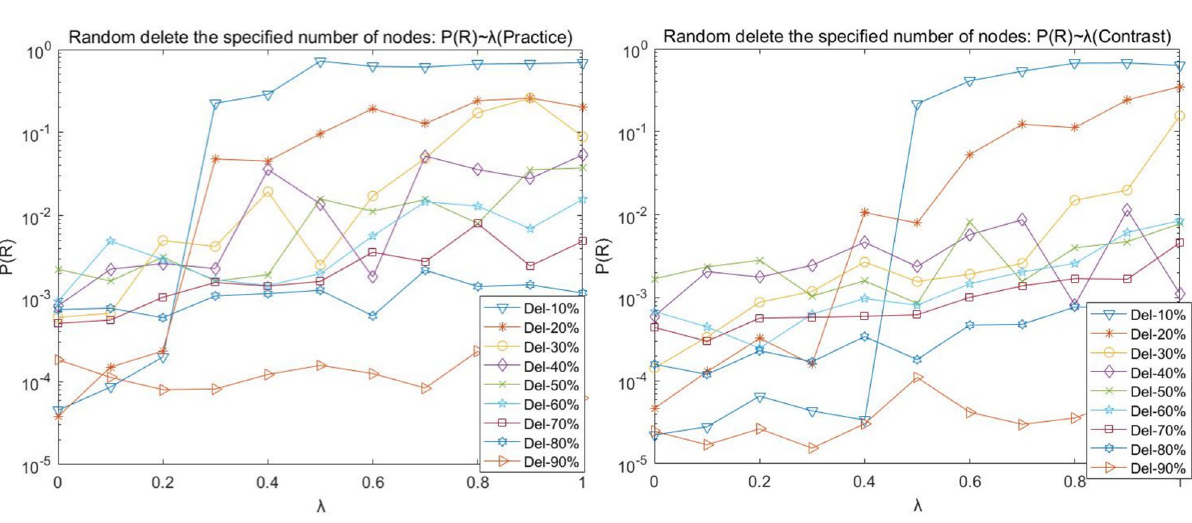
Fig 5. Random disruption- P ( R ) with λ variation